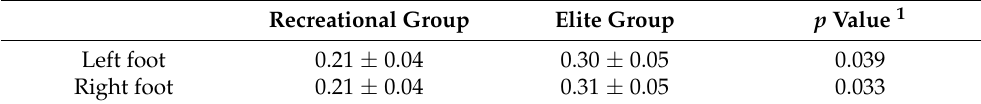
Table 2. Arch Index of the Foot in Static Standing. Recreational Group